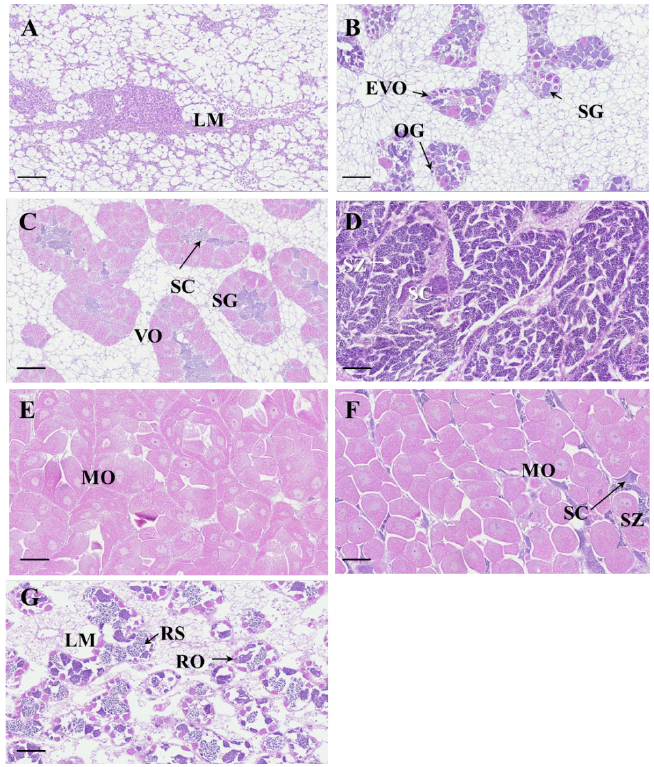
Figure 4. Photomicrographs of histological sections of Ostrea denselamellosa during gametogenesis. ( A ) Resting stage. ( B ) Early gametogenesis stage. ( C ) Advanced gametogenesis stage. ( D – F ) Ma- ture gonad stage of males, females, and hermaphrodites. ( G ) Spawned gonad stage. EVO, early vitellogenic oocyte; LM, lumen; MO mature oocyte; OG, oogonium; RO, relict oocyte; RS, relict spermatozoa; SZ spermatozoa; VO vitellogenic